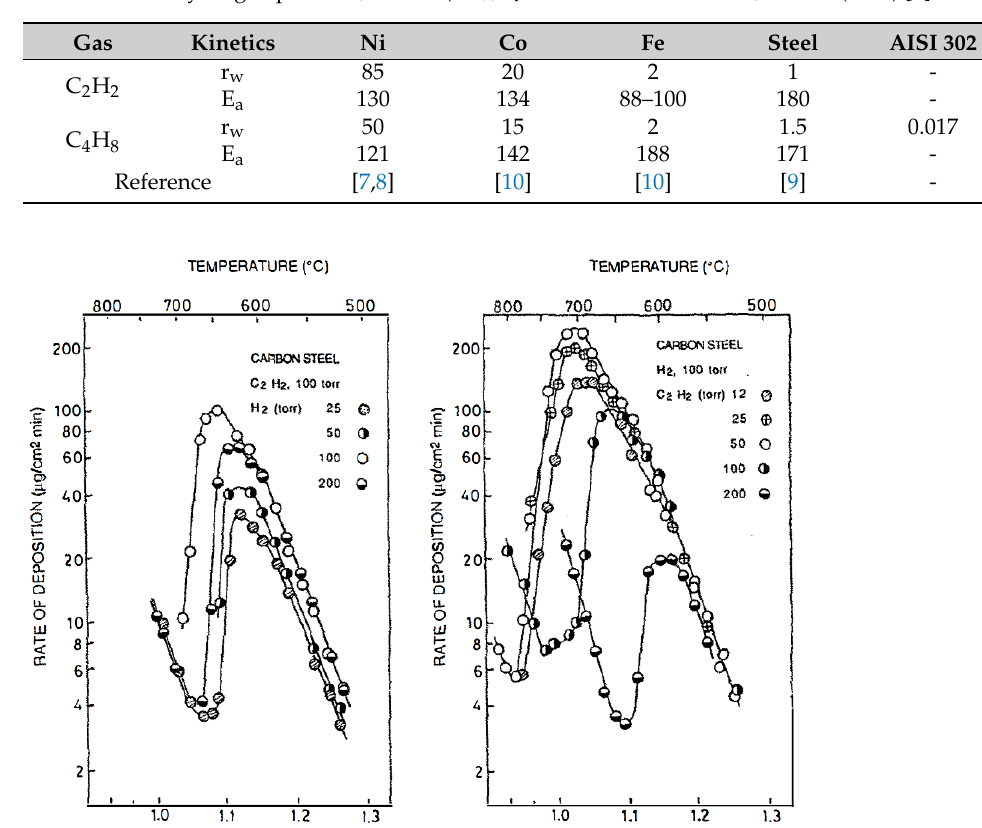
Table 1. Comparison of the rates of carbon formation (r w , µ g/cm 2 min) on Ni, Co, and Fe/steel at T = 500 ◦ C (C bulk diffusion control). Pressures: Hydrocarbon 100 torr, hydrogen 100 torr (except AISI 302 steel: Hydrogen pressure, 500 torr). E a , kJ/mole. Data from Lobo, Franco (1990) [9].